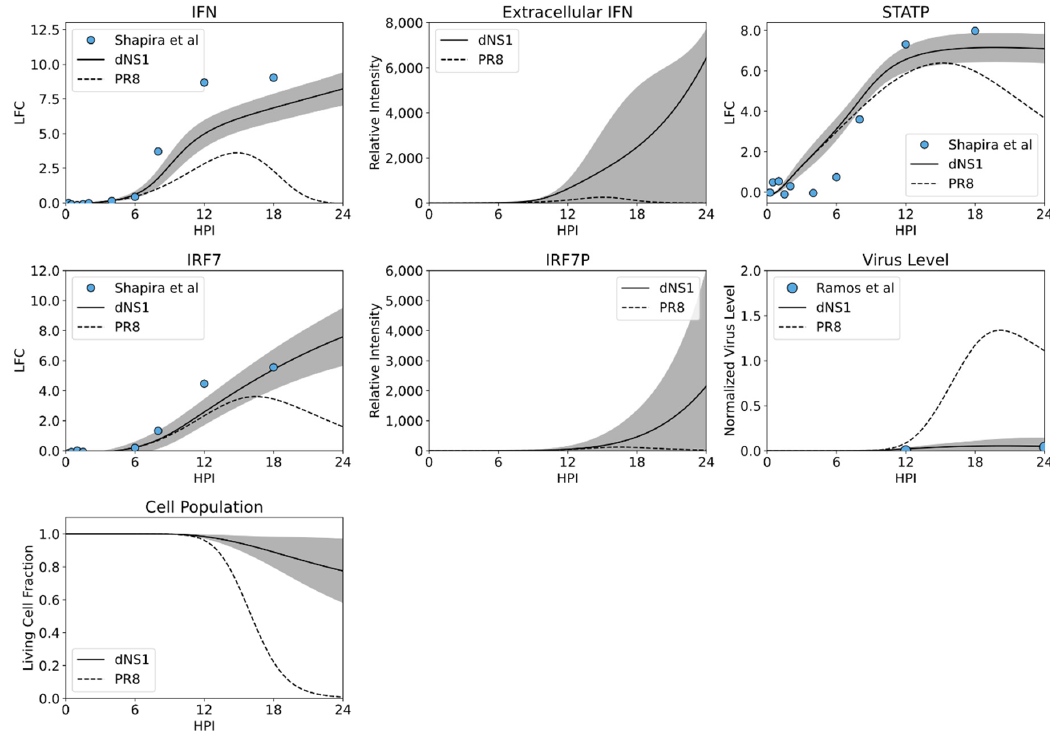
Figure 6. NS1 Knockout Validation Simulation. Solid black lines are the best fitting parameter set. Shaded grey region is ± 1 standard deviation of the best 1000 parameter sets’ simulations (Predicted). Dashed lines show wild-type PR8 best-fit from Figure 2 (Fit). LFC = Log 2-Fold Change of gene expression versus control.